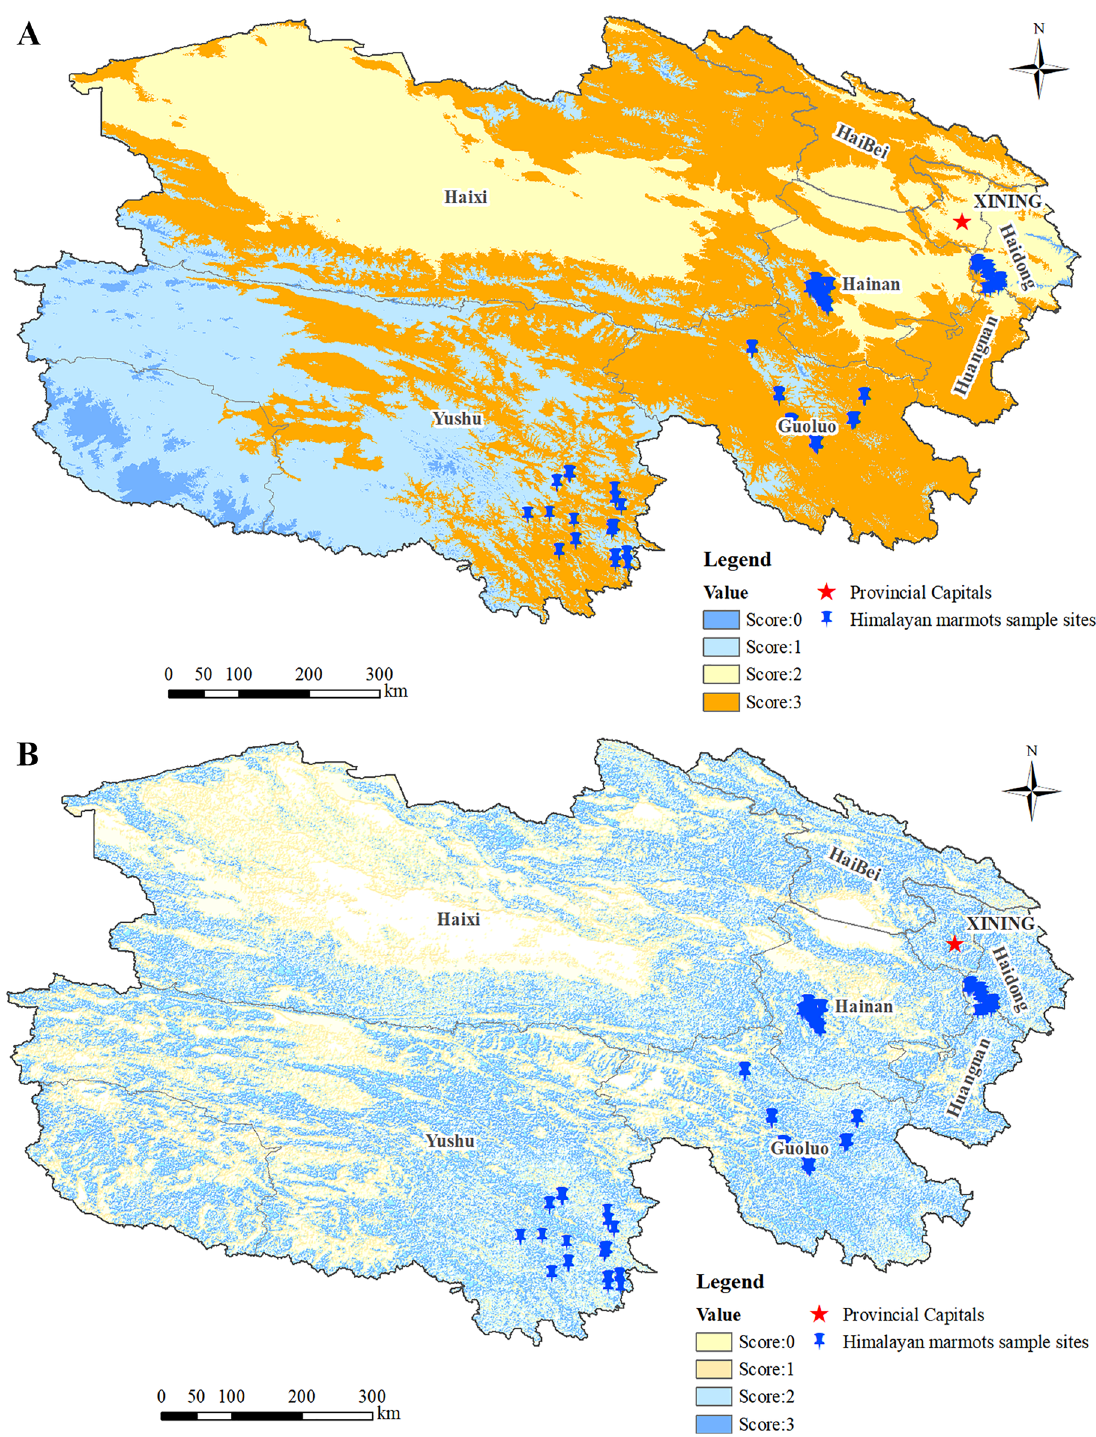
Figure 5. Reclassification based on elevation ( A ); Reclassification based on slope and aspect ( B